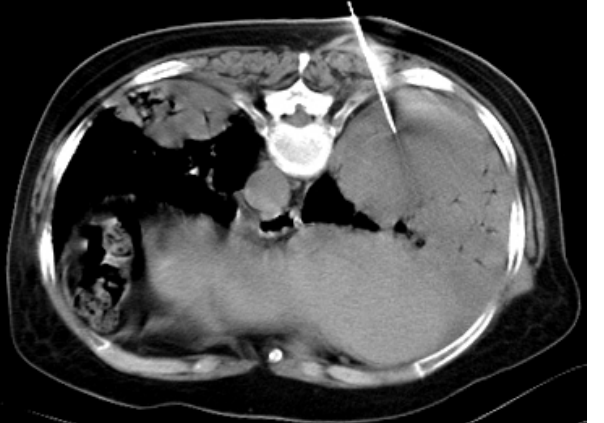
Figure 4: Chest computed tomography after 6 cycles of chemothe- rapy. A B C; mediastinal window: D E F. Blue arrow indicates newly emerging